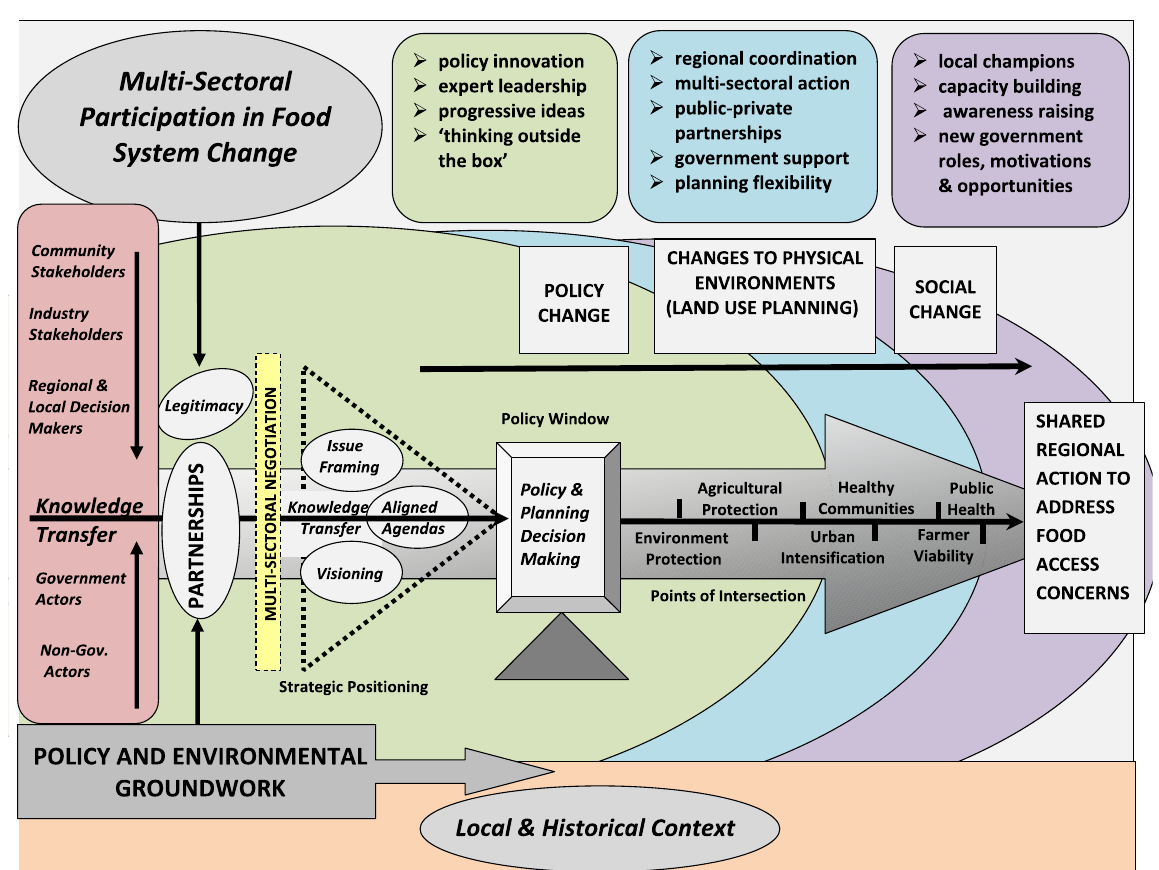
Figure 1. A conceptual framework for multi-sectoral participation and action in food system